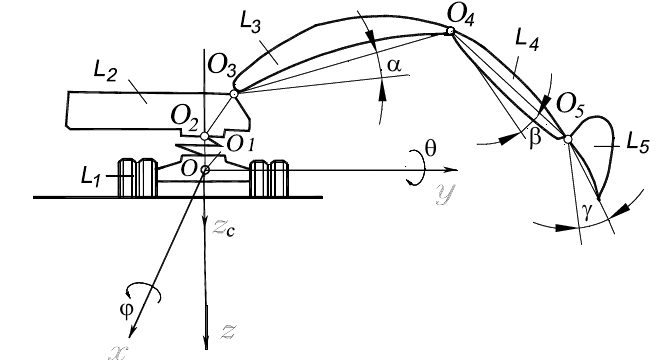
Figure 3  Accepted generalized mechanical system